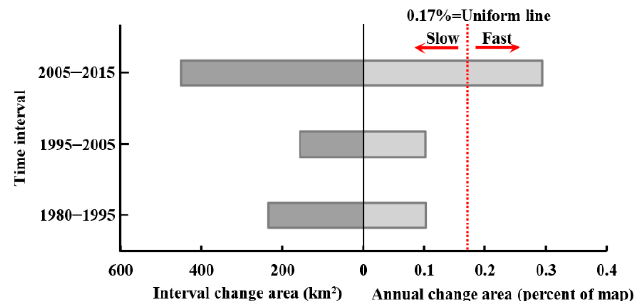
Figure 5. Size and annual change rate by interval from 1980–2015.